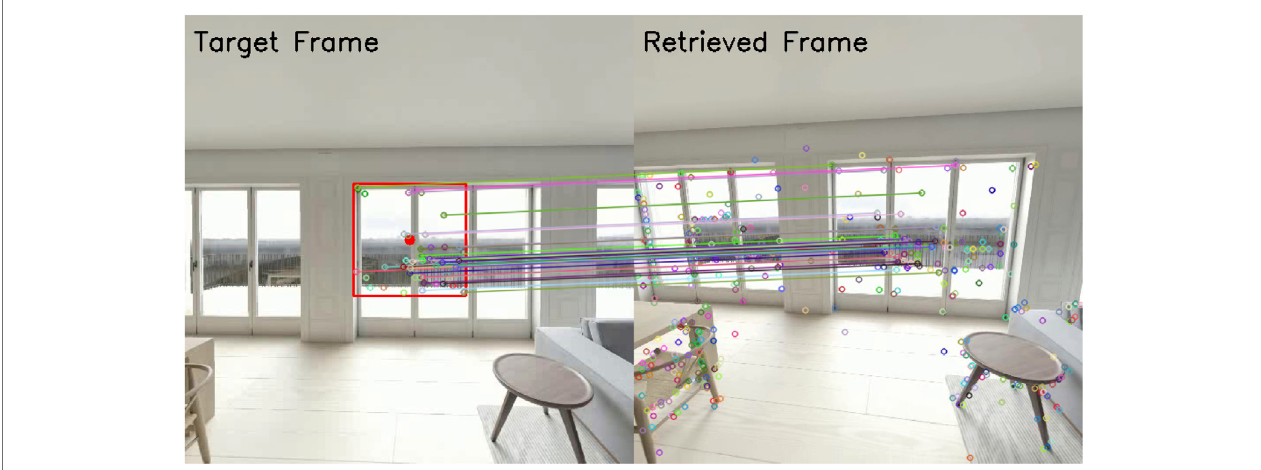
FIGURE 4 | Example showing the matching process to fi nd similar key-points between the retrieved and the query image. The small circles correspond to the positionsoftheimagedescriptorsandtheconnectedlinestothefoundmatches.Notethatthequeryframeusesarestrictedarea(redrectangle)aroundthecurrentgaze position (red dot) that roughly covers the area visible in the fovea of the eye. The region is used to search for frames similar to the query frame.